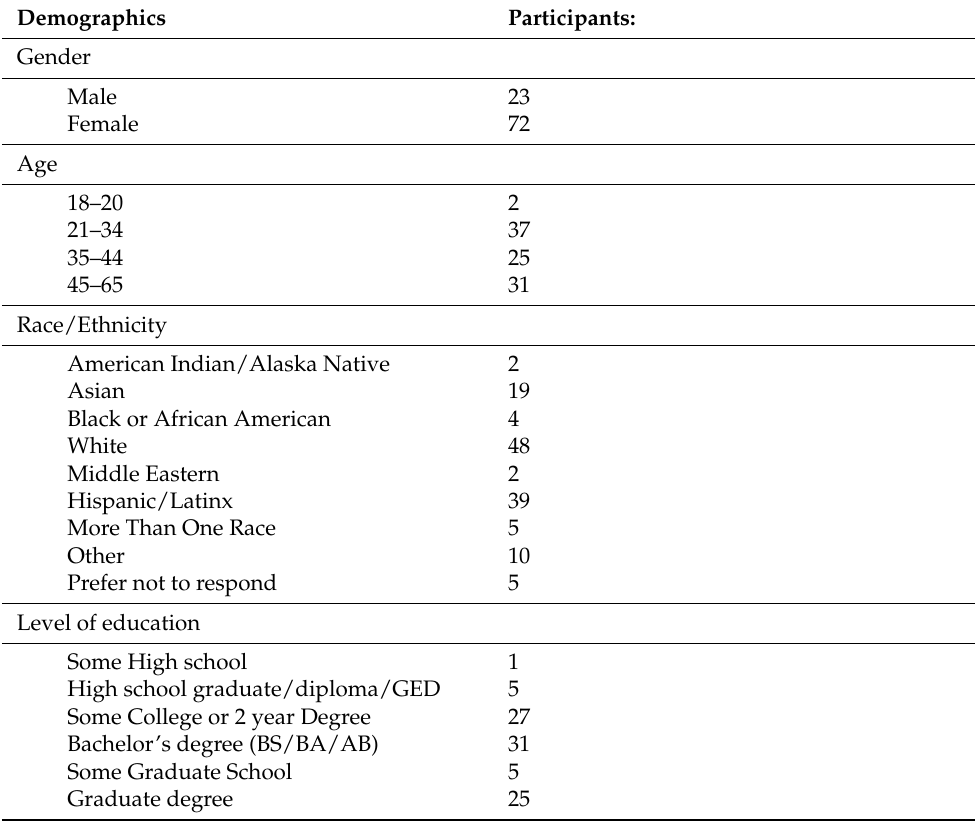
Table 4. HeartSteps II participant